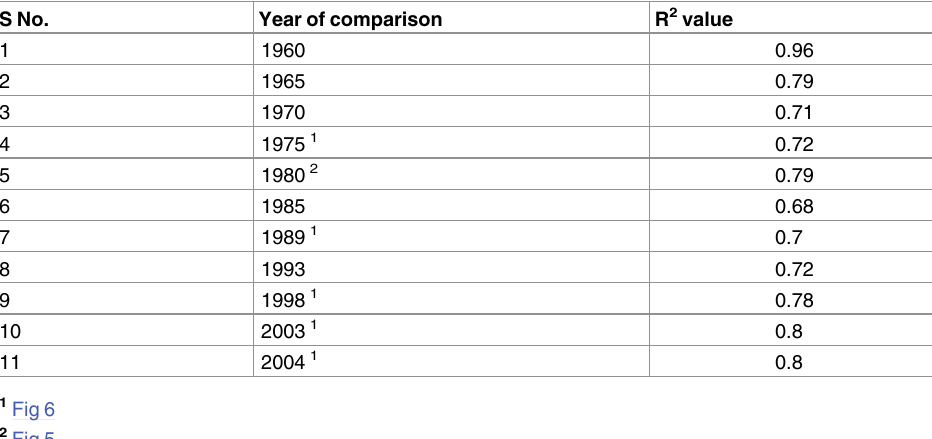
Table 1. Calculated R 2 for selected